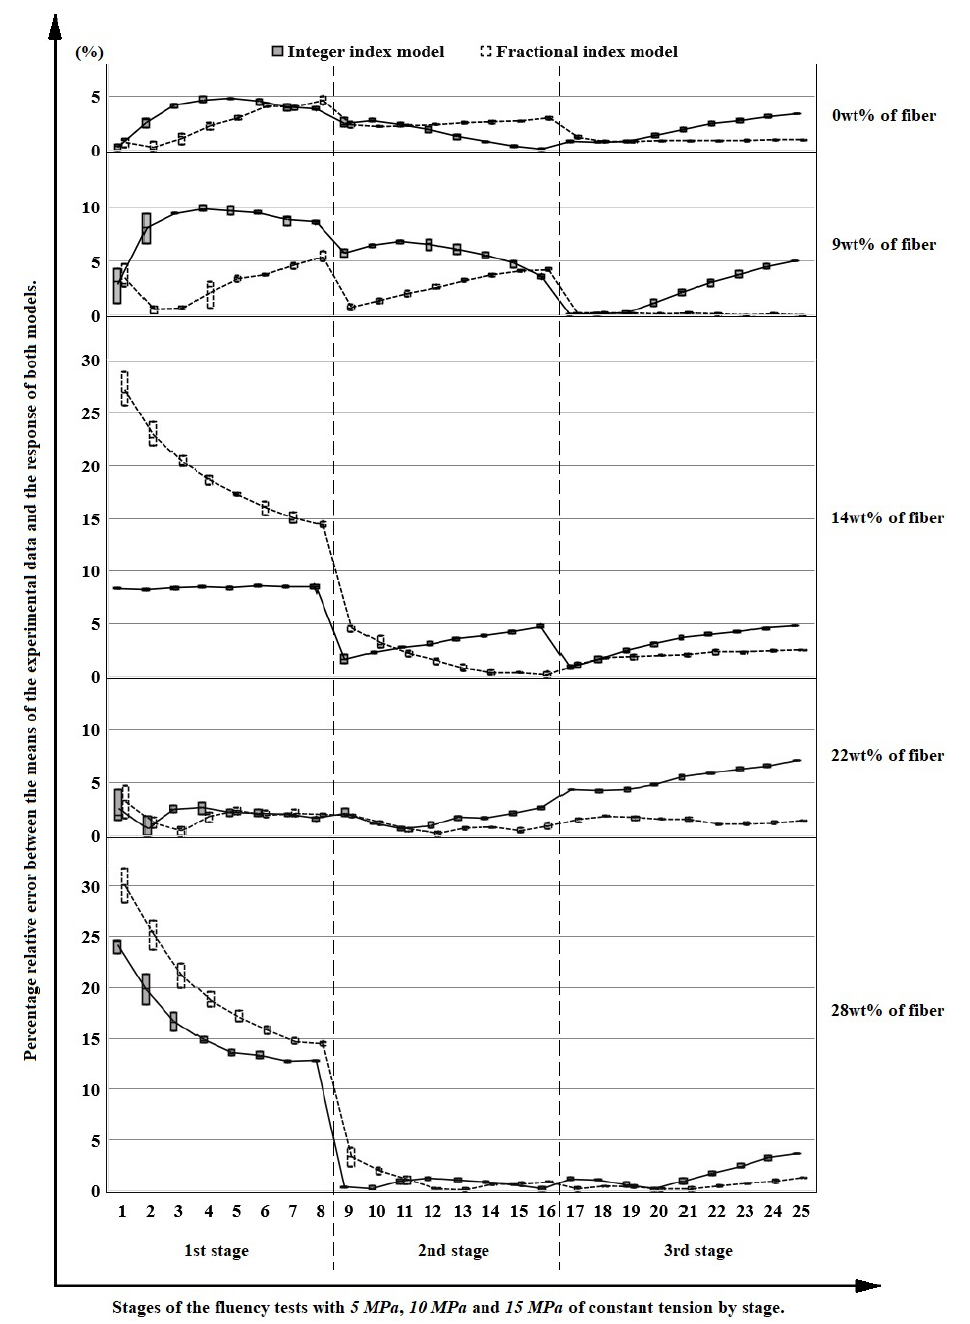
Figure 14. Percentage relative error between the means of the experimental data and the response of both models, integer index model in a continuous line and gray fill, and fractional index model in dashed line and white